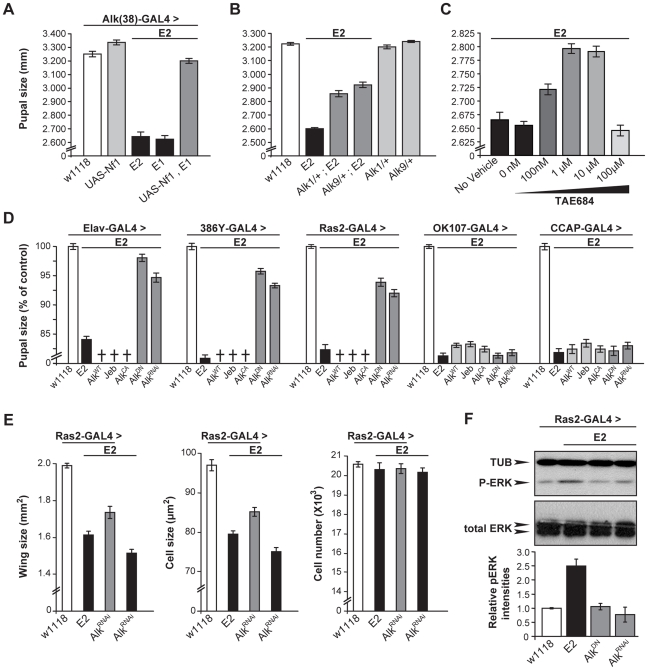
dAlk interacts with dNf1 to control pupal size and ERK activation.(A) Alk(38)-Gal4 over-expression of UAS-Nf1 in Nf1E1/E2 null mutants rescues pupal size (ANOVA F(4,102)  = 240.88, p<0.0001, n≥19). Heteroallelic Nf1E1/E2 mutant flies were used for ease of genetic manipulations. Differences between Alk(38)-Gal4 over-expression of UAS-Nf1 in Nf1E1/E2 background and Alk(38)-Gal4/+ control (p = 0.10) were not significant. (B) Alk1 and Alk9 heterozygous mutations interact genetically with Nf1E2. ANOVA indicated significant differences between Alk1/+;Nf1E2, or Alk9/+;Nf1E2 and Nf1E2 pupal size (F(5,195)  = 390.63, p<0.0001, n≥25). (C) The Alk inhibitor TAE684 ameliorates Nf1E2 pupal size defects. ANOVA indicated significant effects of inhibitor concentration (F(4,565) = 82.42, p<0.0001, n≥100). (D) dAlk down-regulation targeted pan-neuronally, in neuroendocrine and Ras2-expressing cells rescues Nf1E2 pupal size. Significant differences in pupal length were uncovered between Nf1E2 mutants expressing UAS-AlkDN or UAS-AlkRNAi and Nf1E2 alone (F(3,133)  = 176.97, F(3,157)  = 388.14, F(3,135)  = 207.60 for Elav-Gal4, 386Y- Gal4, and Ras2-Gal4 respectively, n≥30 , p<0.0001). Rescue was not observed with MB (OK107-Gal4), or neuropeptidergic (CCAP-Gal4) drivers. Crosses denote lethality. (E) Cell size, but not cell number increases upon rescue of the size defects of Nf1E2 homozygotes by dAlk inhibition. Amelioration of Nf1E2 homozygous mutant size deficits by RNAi-mediated abrogation of endogenous dAlk targeted in Ras2-expressing cells is attributed specifically to increase of cell size and not of cell proliferation. ANOVA indicated significant effects of genotype on wing size (F(3,55) = 99.72, p<0.0001, n≥13) and cell size (F(3,55) = 120.88, p<0.0001, n≥13). No significant effects were uncovered on total cell number (F(3,55) = 0.51, p<0.67, n≥13). Planned pairwise comparisons between Nf1E2 flies without compromised dAlk expression and Nf1E2 flies with abrogated dAlk expression in Ras2-expressing cells showed significant differences on wing size and cell size indicating rescue (p<0.0001 for all comparisons). (F) Attenuation of dAlk signaling restores ERK overactivation in Nf1E2 mutants. Representative immunoblot and semi-quantification (histograms below) of four such blots. The levels of phosphorylated ERK in Nf1E2 mutants were significantly different from w1118 control (p<0.0001, n = 4, Student's t-test) indicating elevation of pERK levels. In contrast, Nf1E2 larvae with compromised dAlk activity have normal pERK levels (p = 0.84 for UAS-AlkDN and p = 0.42 for UAS-AlkRNAi respectively) demonstrating restoration of ERK phosphorylation of Nf1E2-null mutants to normal upon abrogation of dAlk levels or function. Error bars denote S.E.M.